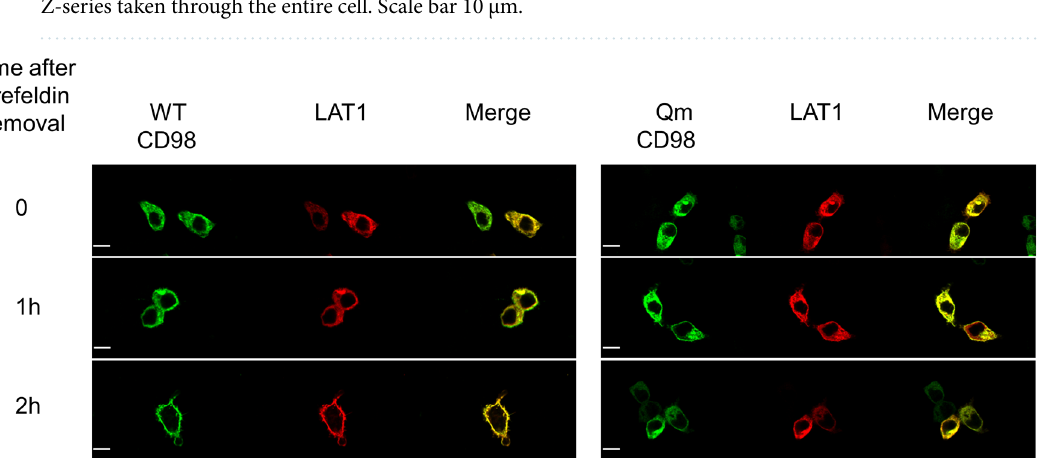
Figure 6. Influence of CD98 trafficking on LAT1 cell distribution. HEK293 cells were transiently co-transfected with LAT1 and WT-CD98 or Qm-CD98 constructs. After 7 h of BFA treatment, cells were washed, fixed and labeled at the indicated times as described in materials and methods. Confocal images show a single, representative, section of a Z-series taken through the entire cell. Scale bar 10